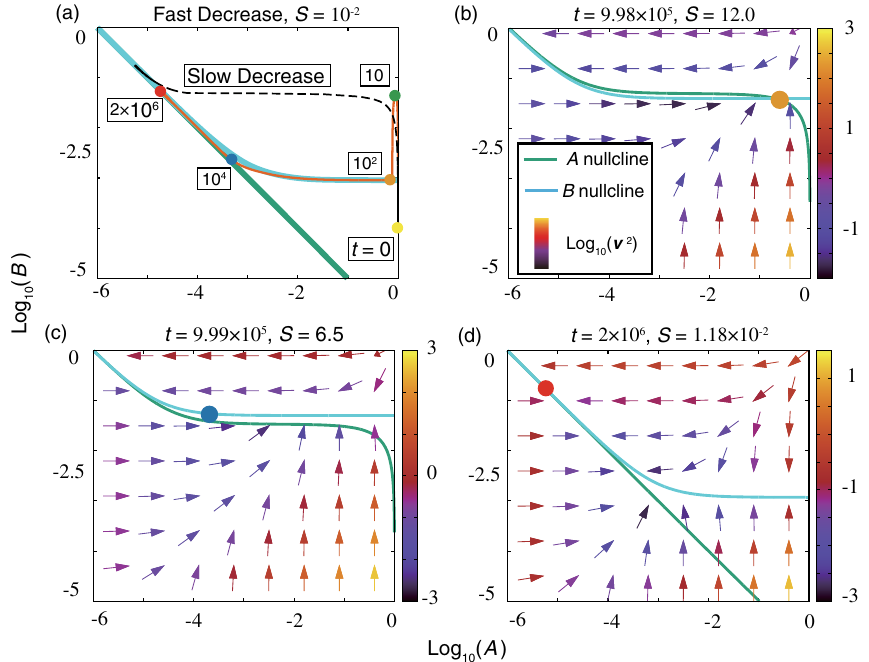
FIG. 4. Movement of nullclines and time evolution of state variables [circles within the state space ð A; B Þ ]. (a) The case of a fast substrate decrease (the orange line indicates the orbit, and numbers in white boxes indicate the time points). The orbit of a slow substrate decrease is also plotted (black dashed line). (b – d) The case of a slow substrate decrease. Each point is the value of the state variable at the indicated time and substrate concentration. The vector field v ¼ ð dA=dt; dB=dt Þ is also depicted. Parameters are identical to those described in Fig.